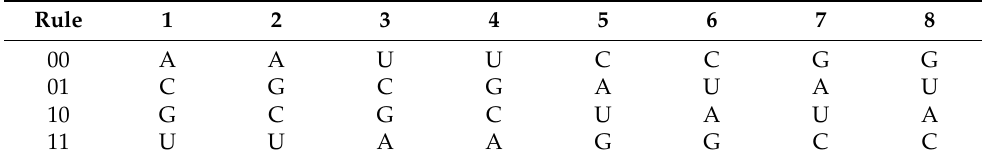
Table 2. Binary coding rules for RNA sequences.